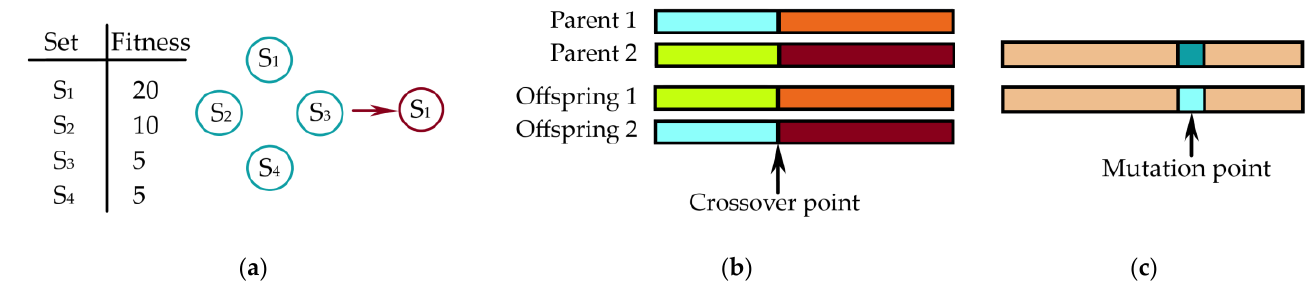
Figure 4. ( a ) Tournament selection; ( b ) single-point crossover; ( c ) uniform mutation.